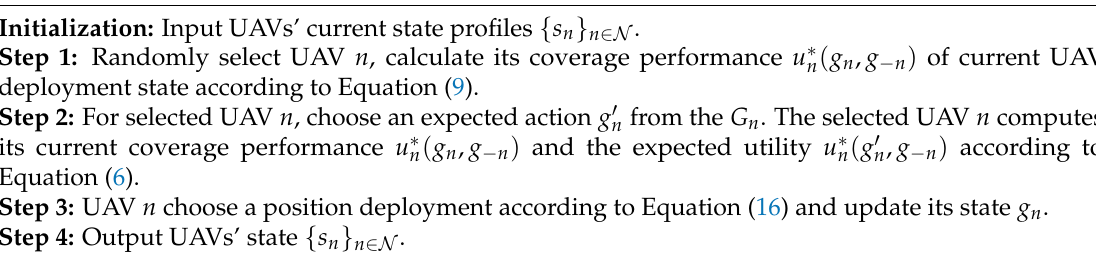
Algorithm 1 . One time coverage optimization deployment algorithm based on Binary log-linear learning